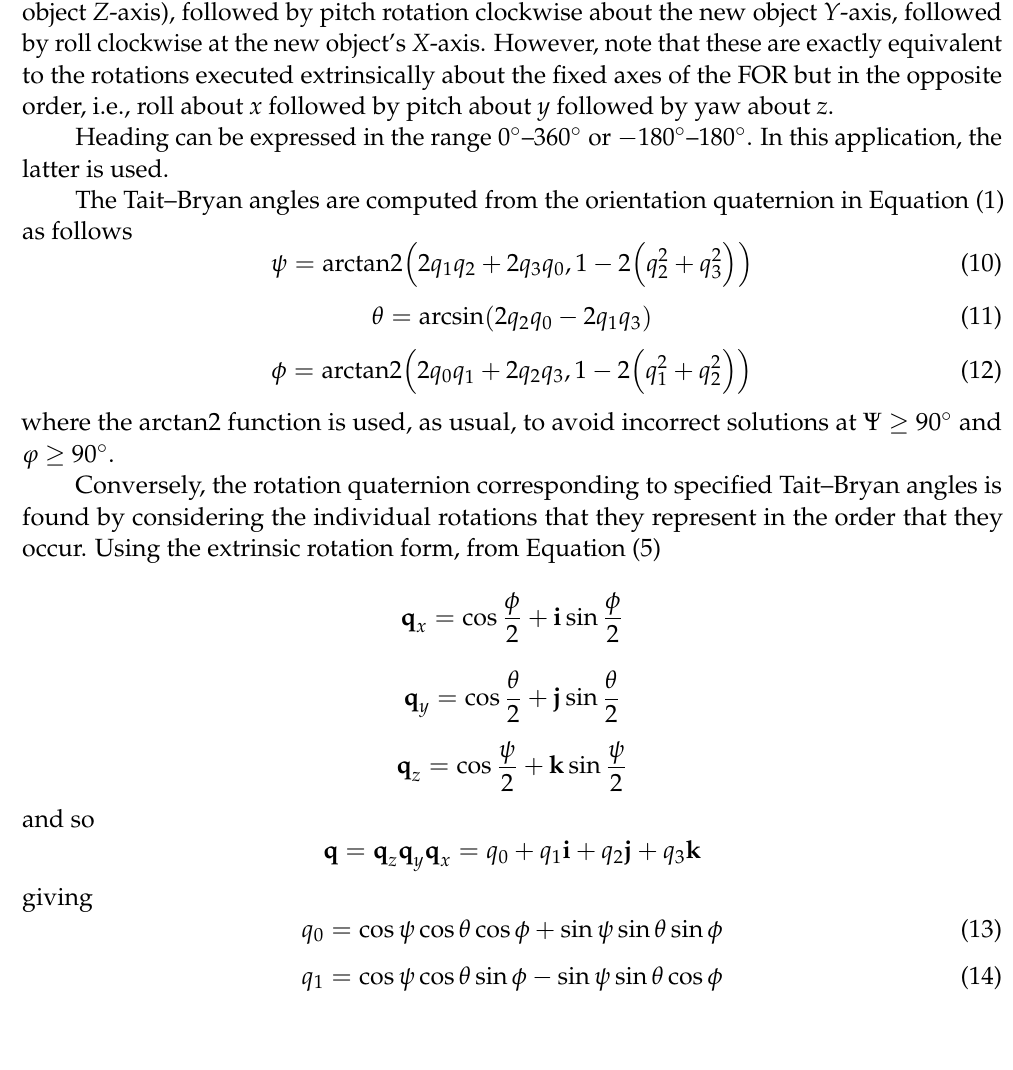
z -axis points down. In the earth’s FOR, x is north and y is east. The rotations are generally